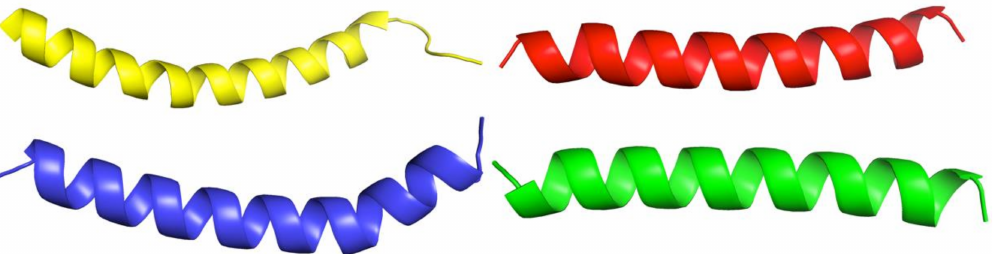
Figure 3. Visual comparison of the structures of LL-37 (yellow; PDB ID: 2K6O) and synthesized peptides: PEP-137—blue, PEP-38—red, PEP-36—green (by